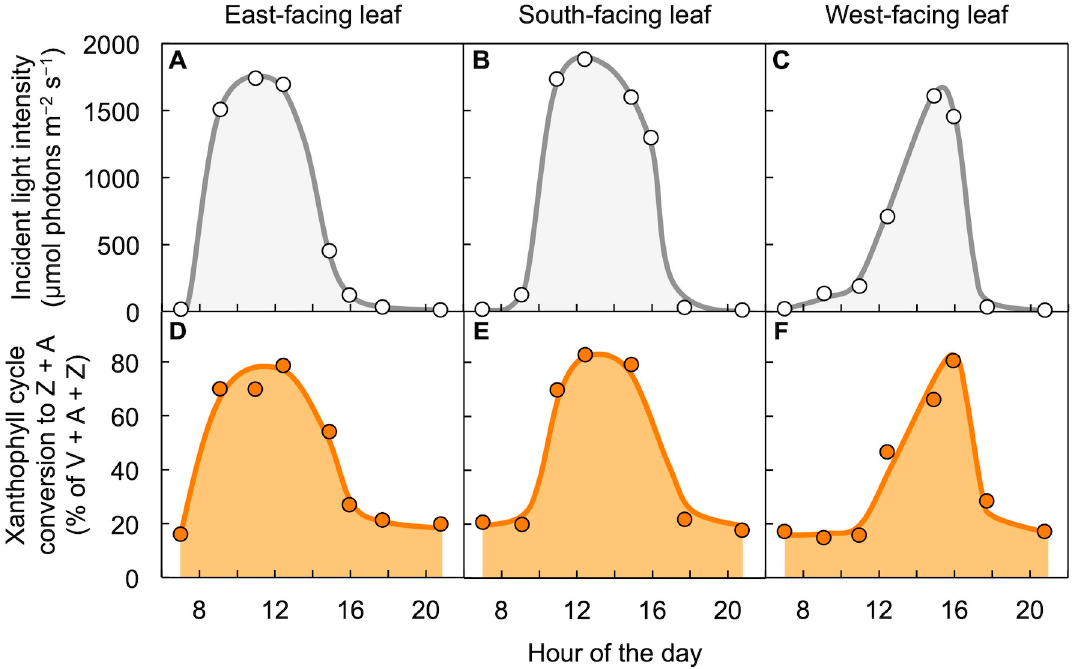
Figure 5. Diurnal characterization of the conversion state of the xanthophyll cycle in east-, south-, and west-facing leaves of Euonymus kiautschovicus on a sunny day (25 October 1990). ( A – C ) Direct sunlight incident on the upper leaf surfaces and ( D – F ) percent of the xanthophyll cycle converted to zeaxanthin and antheraxanthin (Z + A). V = violaxanthin. Data are from Adams et al. [41].